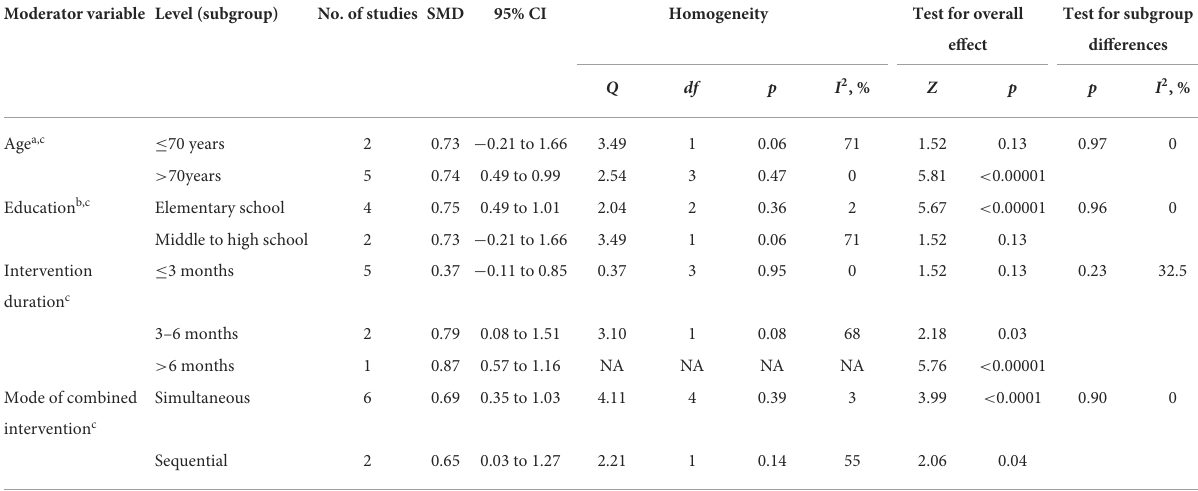
TABLE 3 Effects of moderators on the efficacy of combined intervention to improve cognition in older adults with MCI after sensitive analysis. Moderator variable Level